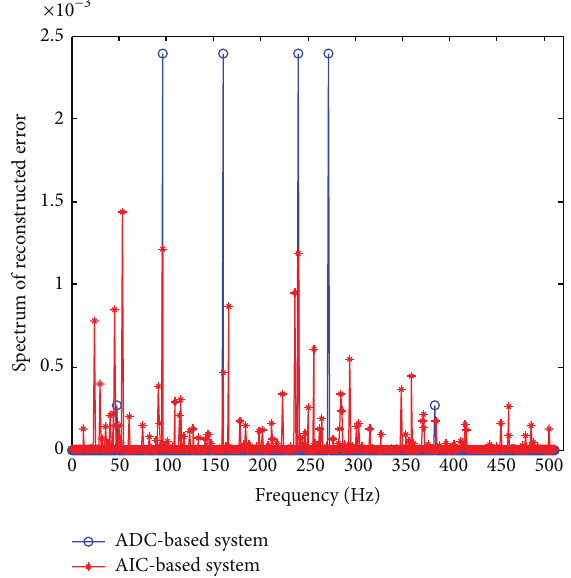
Figure 3: Spectrum of reconstruction error comparison between the conventional ADC-based system and the AIC-based system.